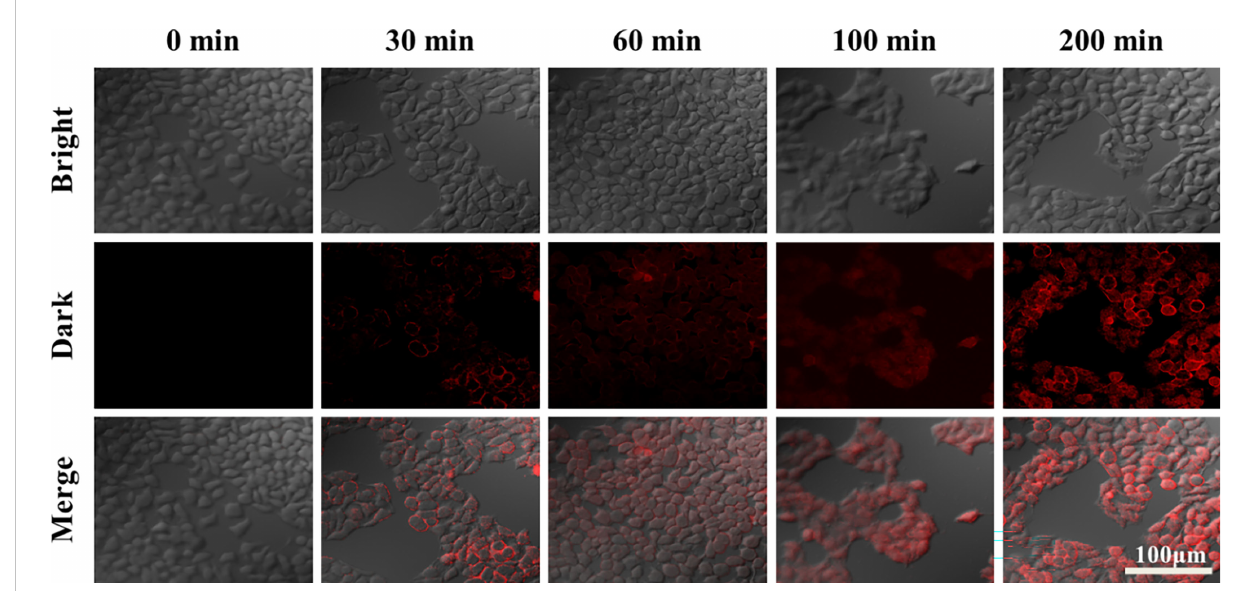
FIGURE 8 CLSM images of HepG 2 cells after 200 m g/mL of ZD-CAR nanoparticles were incubated with different times (dyeing with